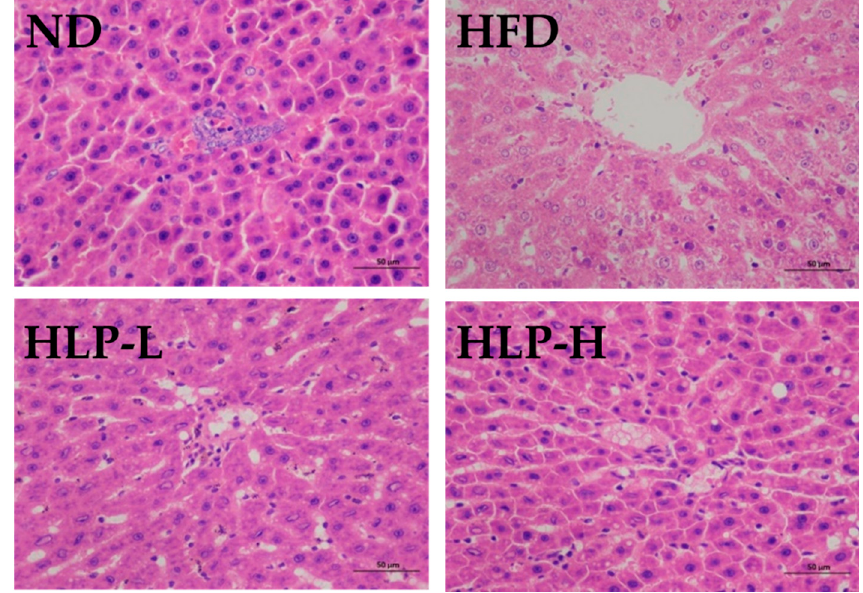
Figure 5. Histological assessment of livers (H&E stain, 200 × magnification).